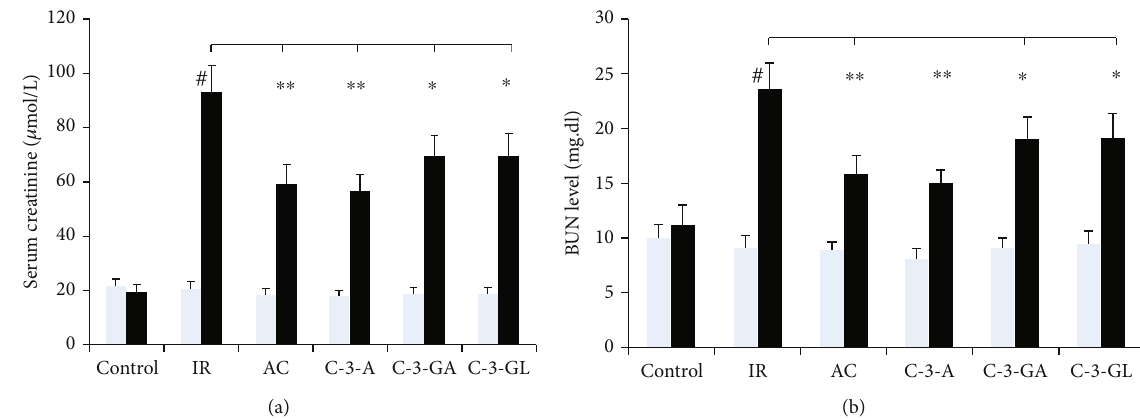
Figure 2: Serum creatinine and blood urea nitrogen levels in the renal IR injury and anthocyanin treatment. The data are the means ± SD . n = 13 per group. IR: ischemia/reperfusion; AC: anthocyanins; C-3-A: cyanidin-3-arabinoside; C-3-GA: cyanidin-3-galactoside; C-3-GL: cyanidin-3-glucodise. The comparison between treated mice and IR was indicated by asterisks. # P < 0 : 01 vs. control within group; ∗ P < 0 : 05 and ∗∗ P < 0 : 01 vs. respective IR group.